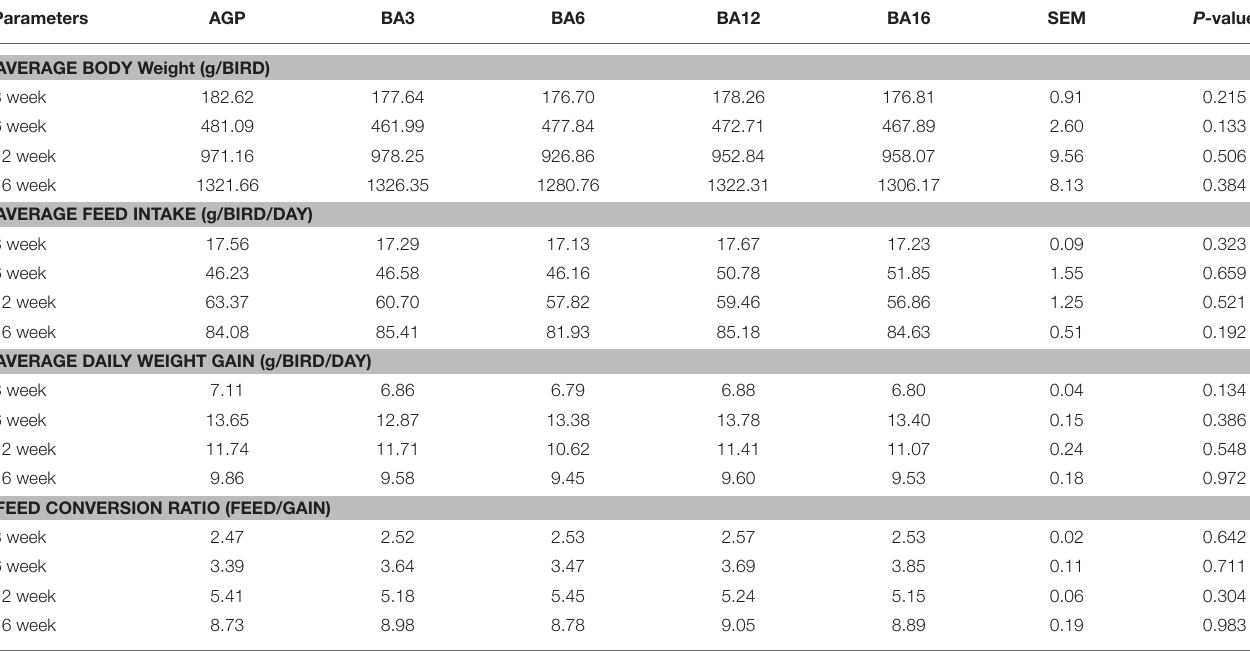
TABLE 3 | Growth performance in pullets fed on different dietary treatments from 0 to 16